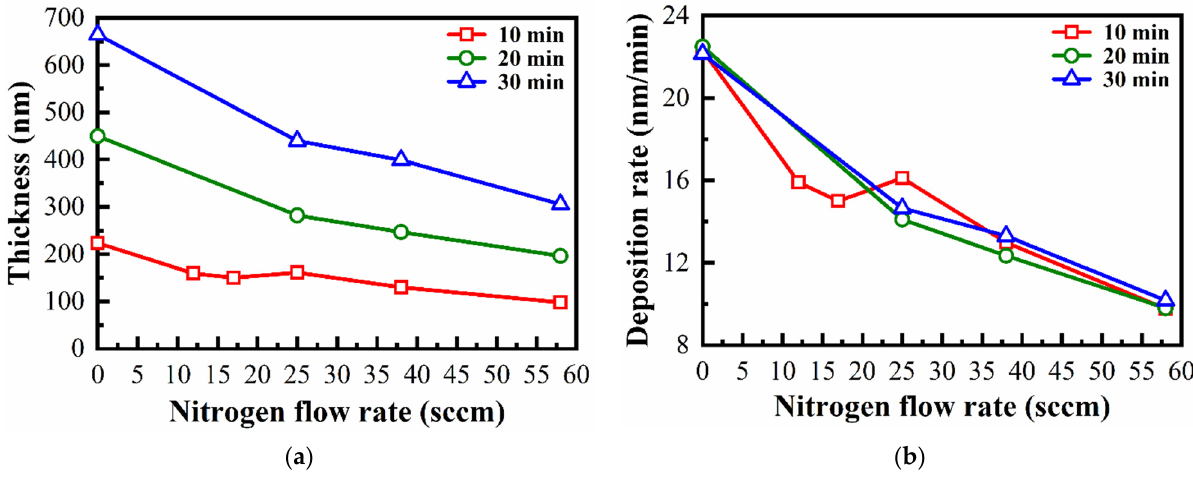
Figure 1. Change of Ta(N) film thickness measured by Dektak step meter ( a ) and the deposition rates ( b ) for different nitrogen flows and sputtering time.